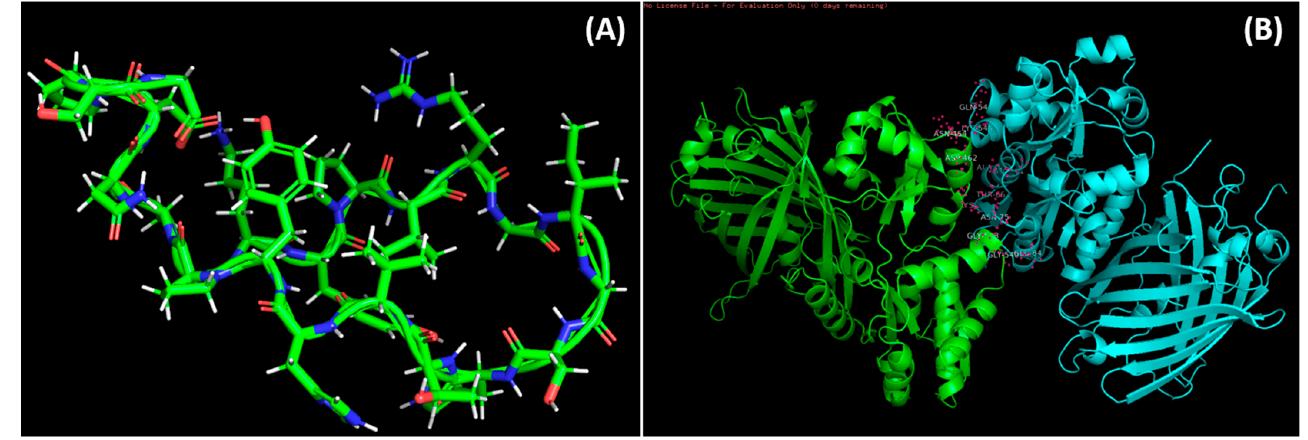
Figure 4. Docked complexes of the vaccine and the epitopes. ( A ): Predicted structure of modeled vaccine construct using a Swiss model. ( B ): Molecular docking of epitopes with 2a37 complement c3 receptor.